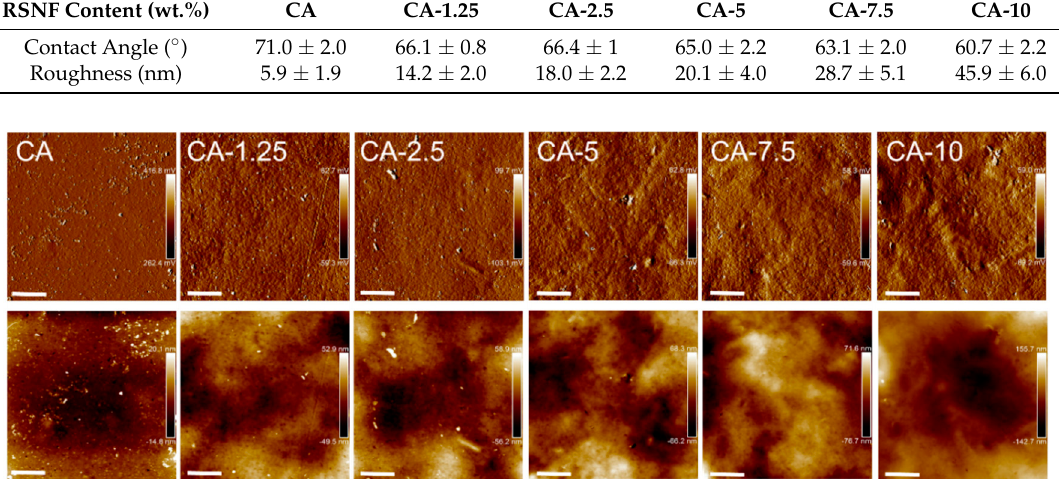
Table 2. Porosity and surface area characteristics of CA and CA/RSNF films.